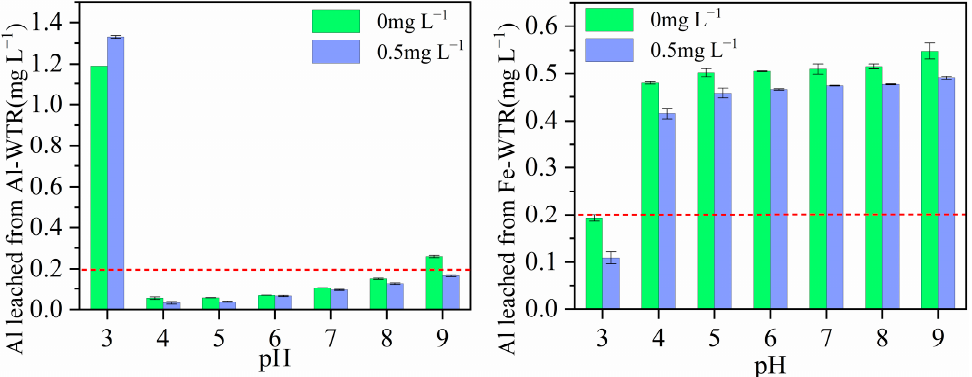
Figure 5. Effect of different pH conditions on the leaching of Al in Fe-WTR and Al-WTR.